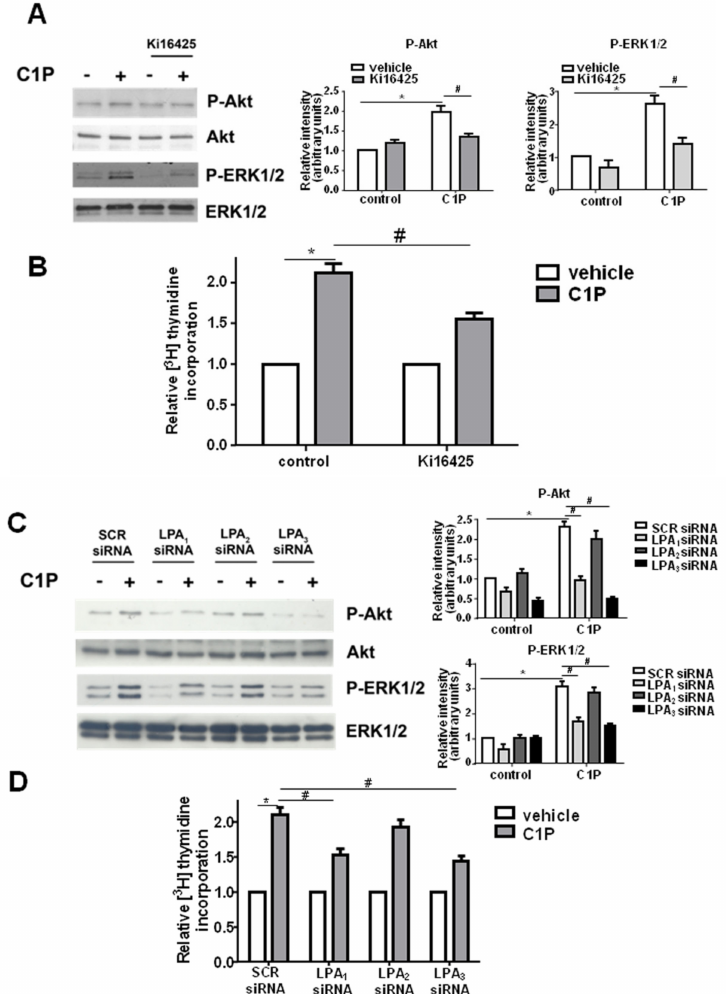
Figure 4. The mitogenic effect of C1P relies on LPA 1 and LPA 3 engagement. ( A ) Overnight serum-starved C2C12 myoblasts were pre-incubated for 30 min in the presence or absence of 2.5 µ M Ki16425 before being stimulated with 15 µ M C1P for 5 min. Left panel: ERK1/2 and Akt activation was measured in total cell lysates by Western blot analysis using anti-phospho-ERK1/2 and anti-phospho-Akt antibodies. A blot representative of three independent experiments is shown. Right panels: Band intensity was quantified by densitometric analysis and normalized to the expression of total ERK1/2 and total Akt, respectively. C1P activates ERK1/2 and Akt in a statistically significant manner by Student’s t test (* p < 0.05); the effect of LPA 1/3 inhibition by Ki16425 was statistically significant by two-way ANOVA followed by Bonferroni’s post hoc test ( # p < 0.05). ( B )